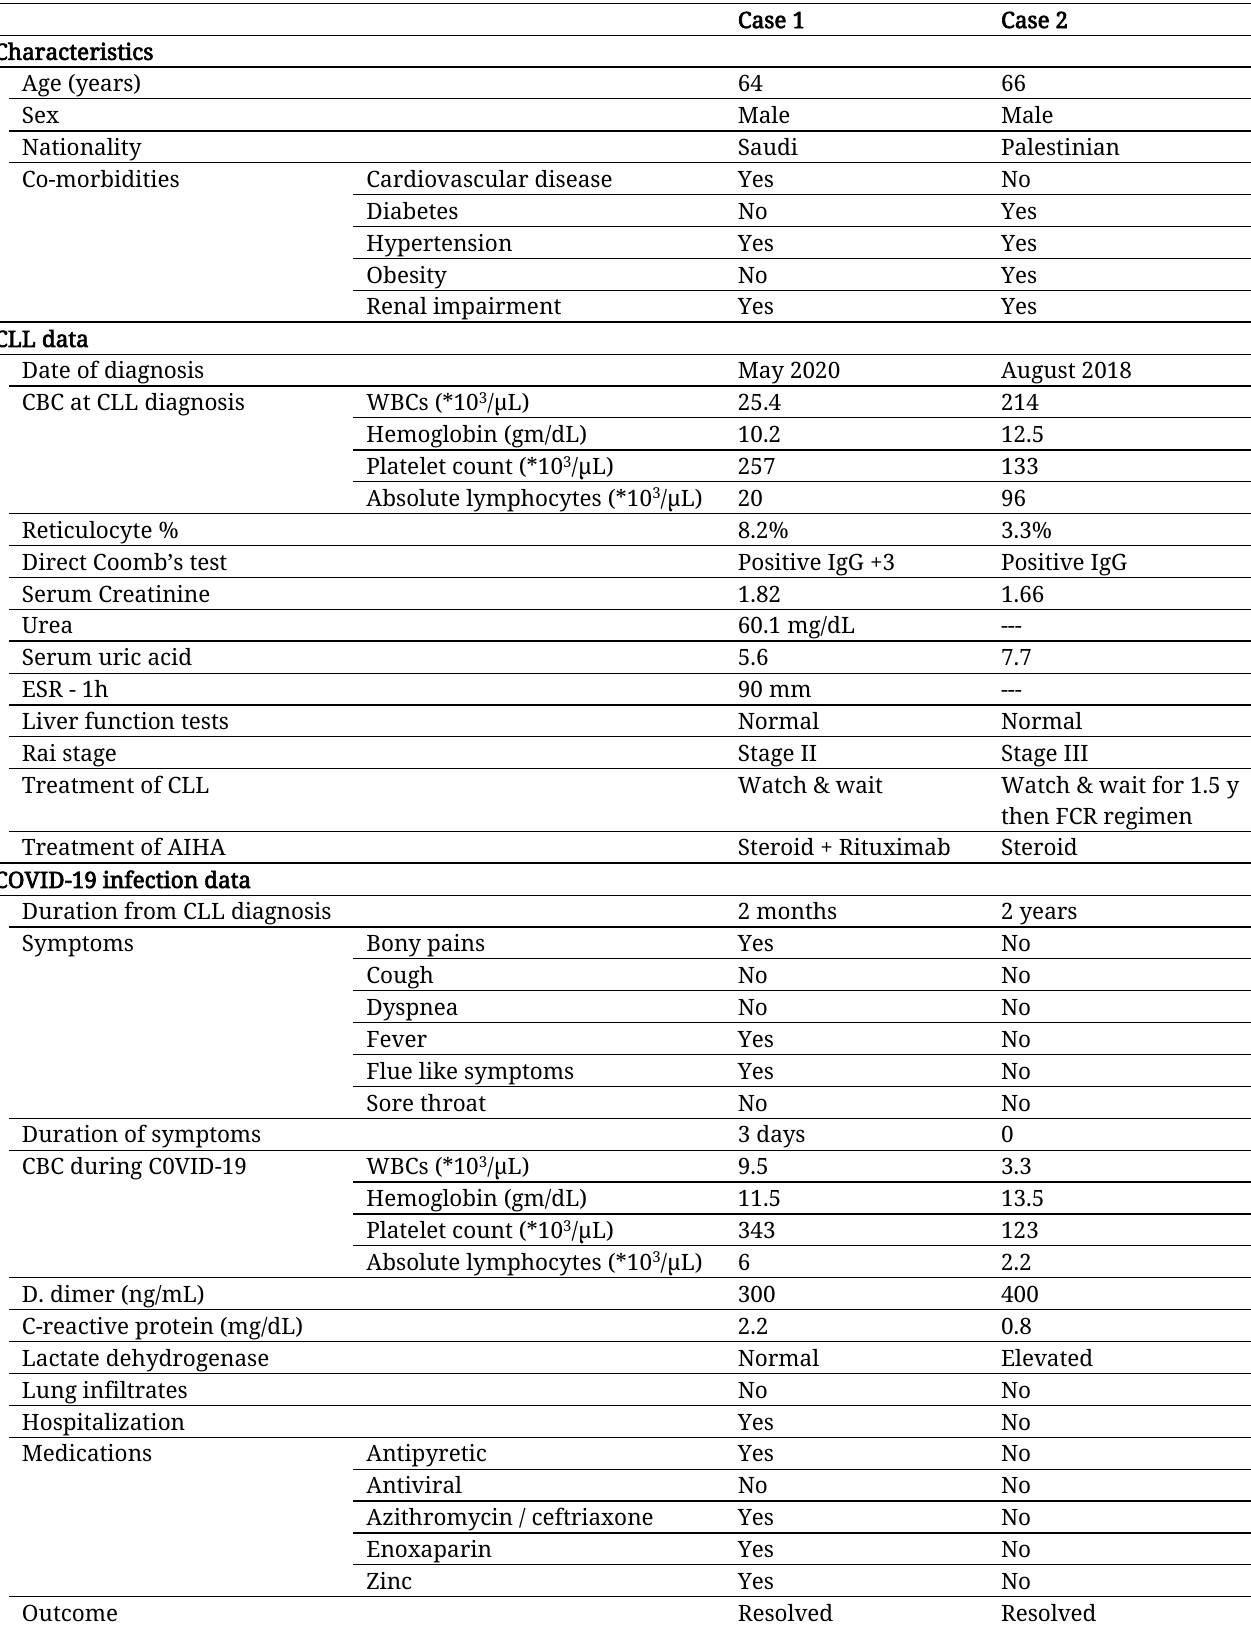
Table 1: Characteristics of the two reported cases and summary of CLL and COVD-19 infection data